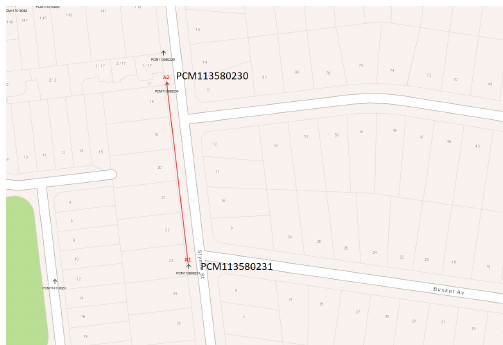
Figure 4. Locations of survey data